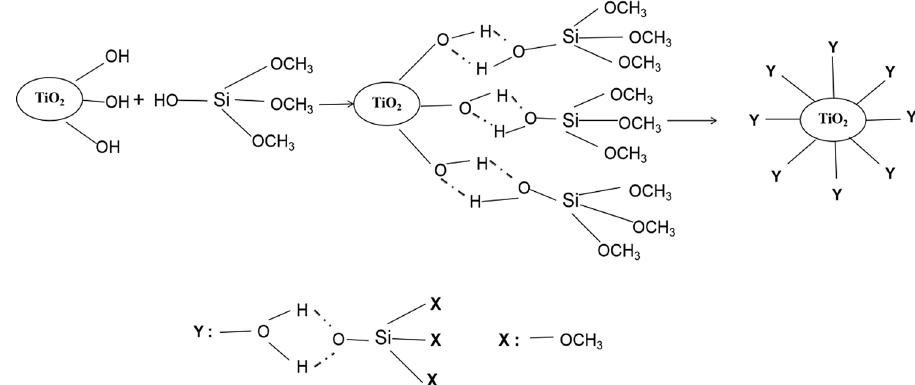
Figure 1: Mechanism of KH - 570 - modi fi ed nano - TiO 2